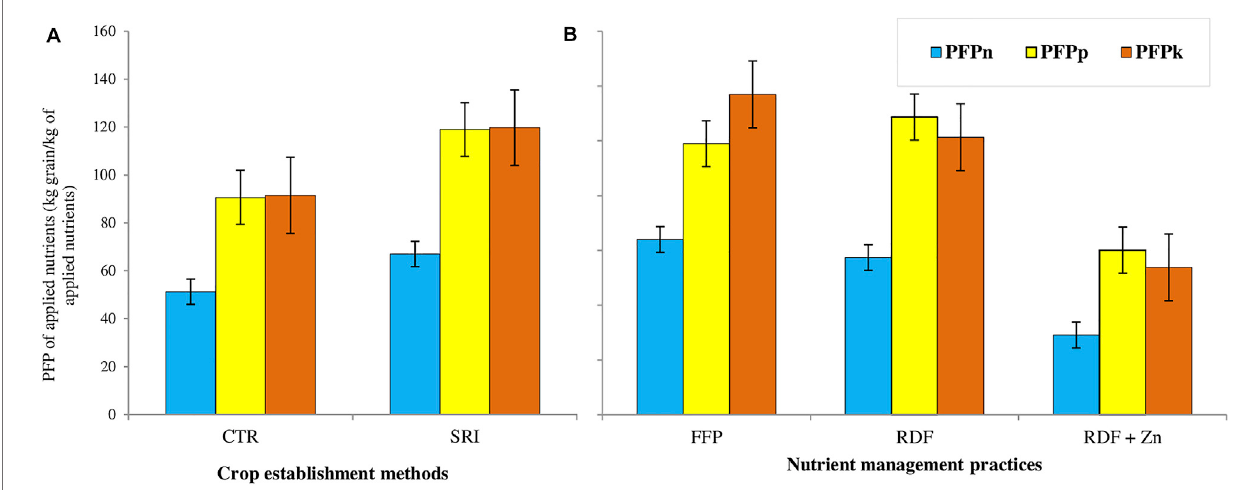
FIGURE 7 | In fl uence of different (A) CEMs and (B) NMPs on the partial factor productivity (PFP) of applied nutrients viz . PFP n , PFP p , and PFP k in rice (4 year av.). The vertical bars indicate the LSD at p = 0.05.